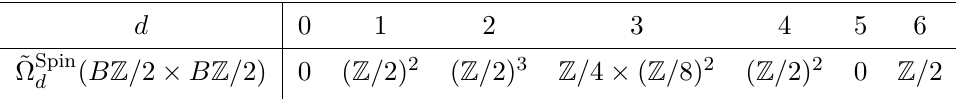
Table 5. The reduced spin bordism groups of B Z / 2 × B Z / 2 up to degree 6